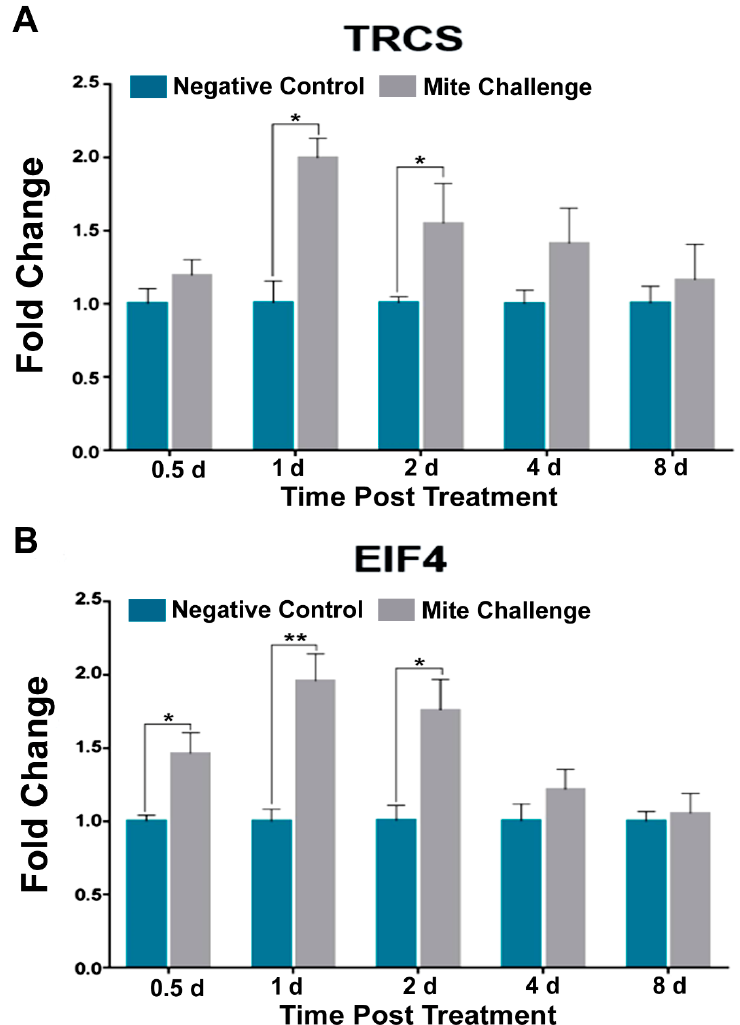
Figure 4. Fold chance of the transcription profiles for pieces of TOR pathway between the negative control (without Varroa challenge) and bees challenged with Varroa mites at different time points post treatment (days). ( A ) TOR subunit TRCS and ( B ) translation initiation factor EIF4 demonstrating similar expression patterns to Toll pathway components of immunity (* p < 0.05, ** p < 0.01). The Jak-Stat signaling pathway has an important role in the control of immune responses. We observed that E3-ubiquitin ligase (CBL) and the transcription factor STAT levels were elevated nearly two and three-fold after one day of treatment, respectively, for challenged bees ( p <